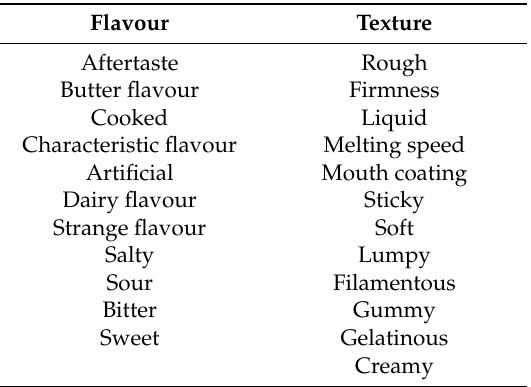
Table 2. Attributes used in the PP + CATA